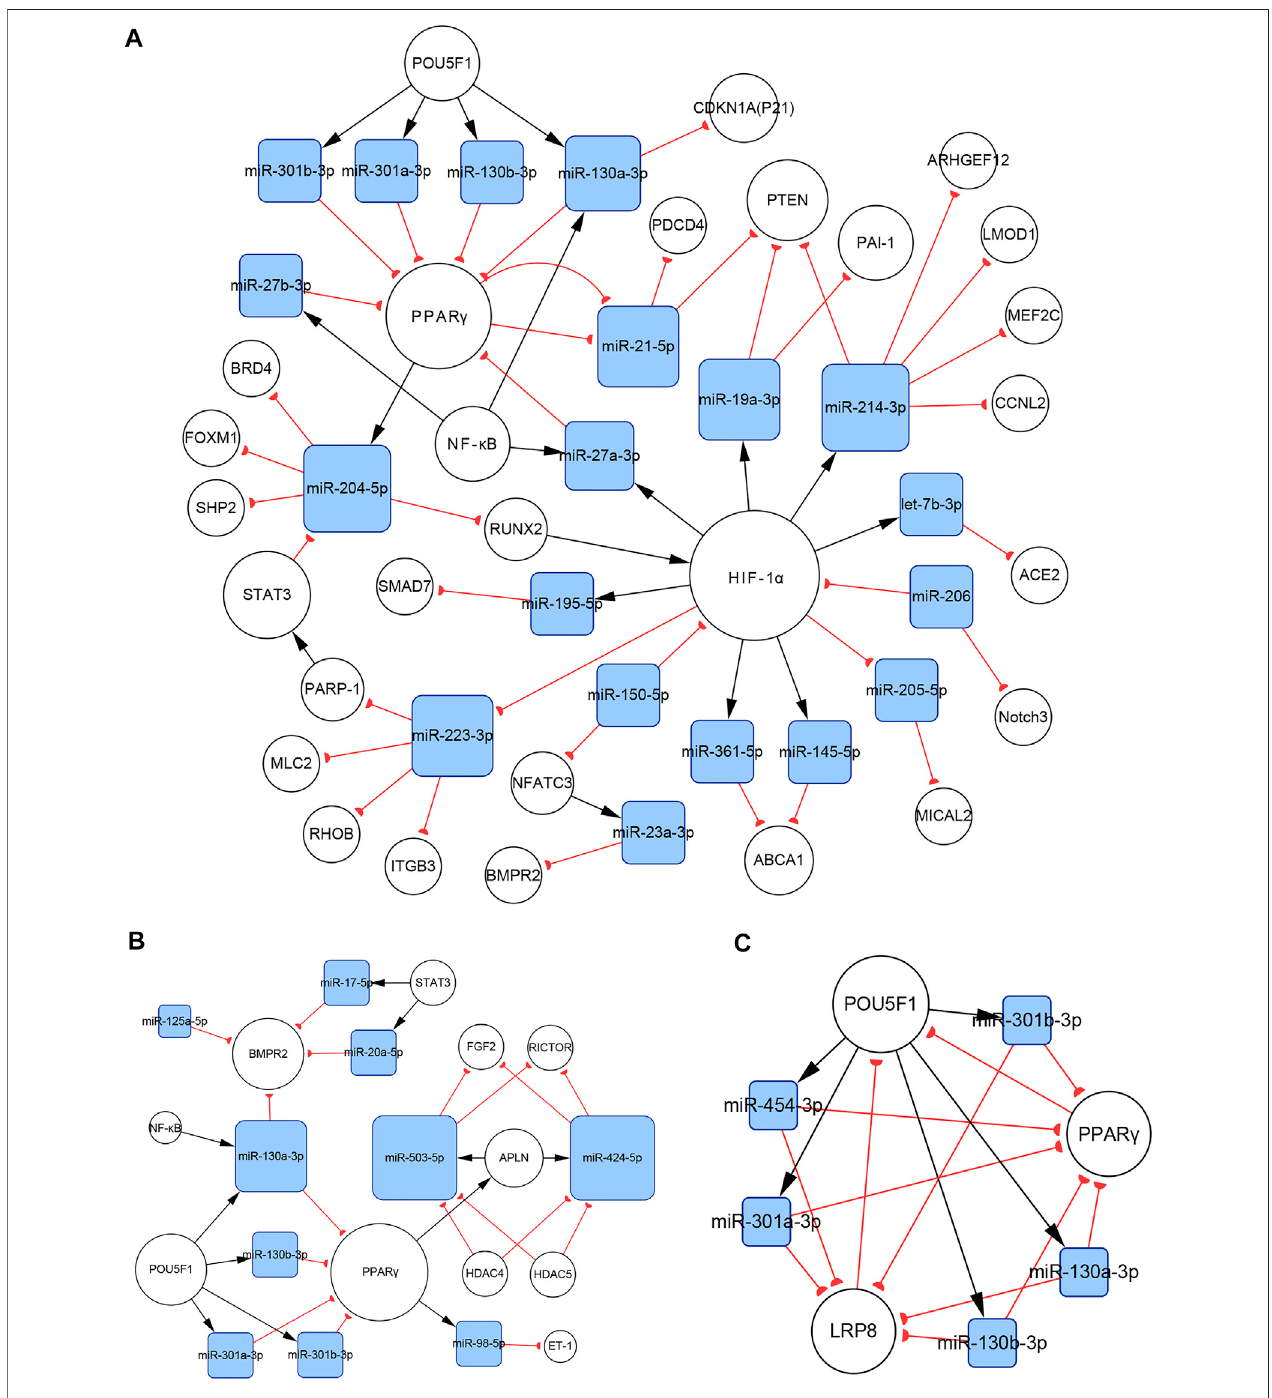
FIGURE 8 | The miR-130/301 family subnetworks in (A) PASMCs, (B) PAECs, and (C) PAFs. This miRNA family was involved in multiple processes, such as cell proliferation, apoptosis, migration, endothelial contraction, and matrix remodeling.